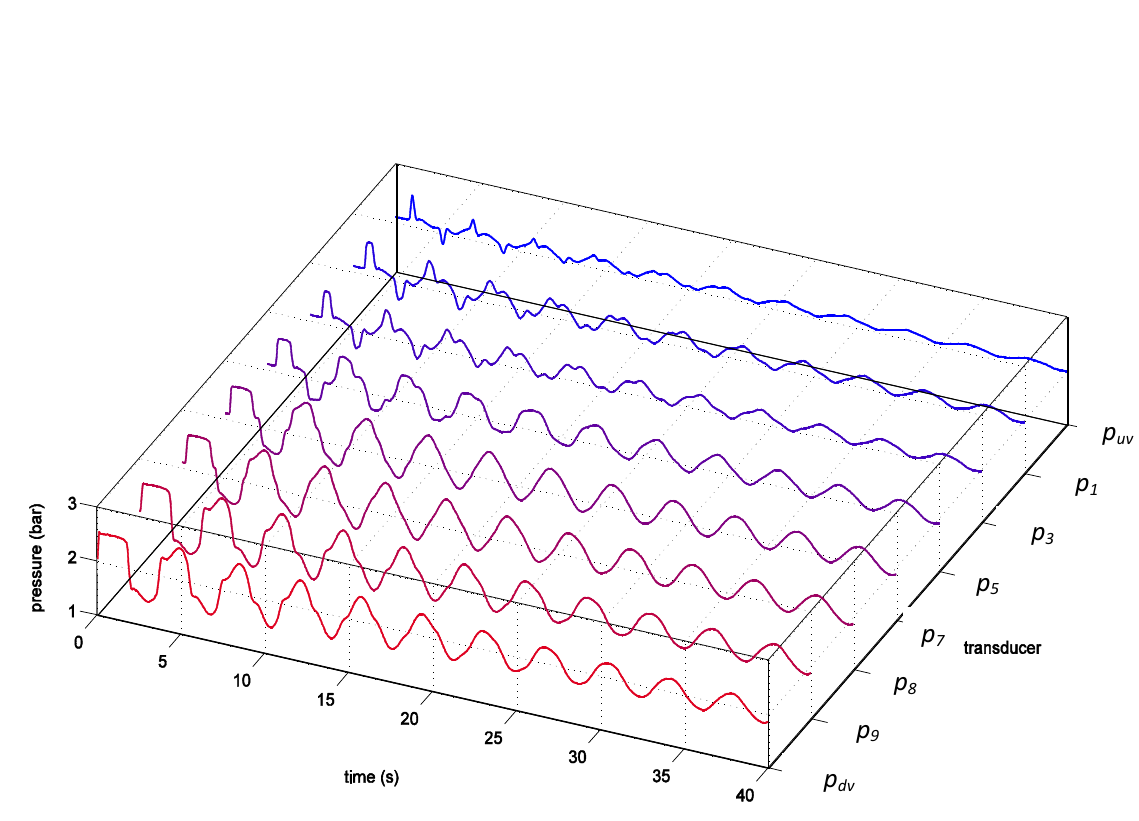
Fig 12. Pressures (averaged over time) measured by the indicated